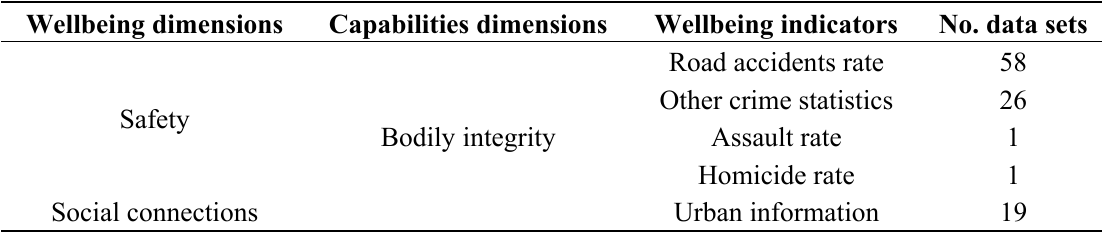
Table 6. Data sets for the bodily integrity capability dimension and its related wellbeing dimensions/indicators